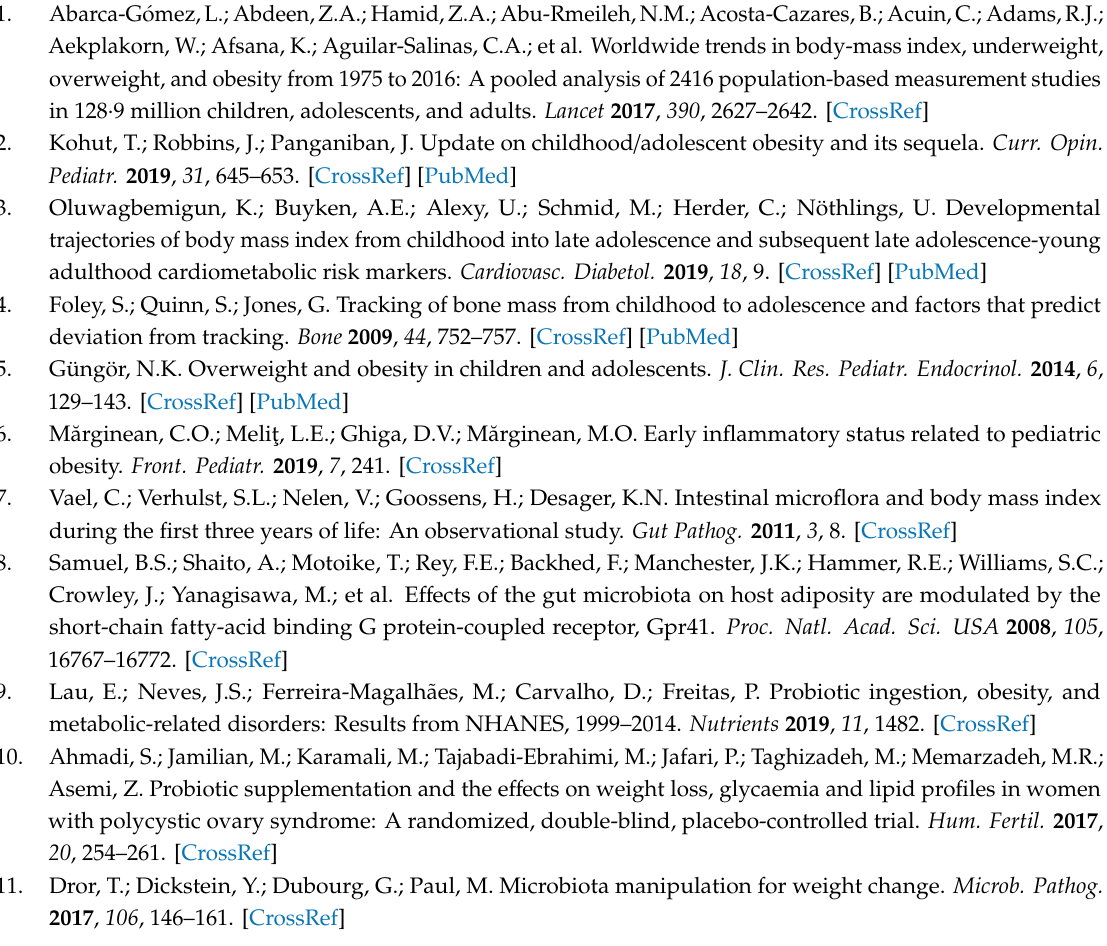
Figure S1: SCFAs and lactate determination by HPLC; Alpha-diversity reflected as Shannon Index; Figure S2: Alpha-diversity reflected as Shannon